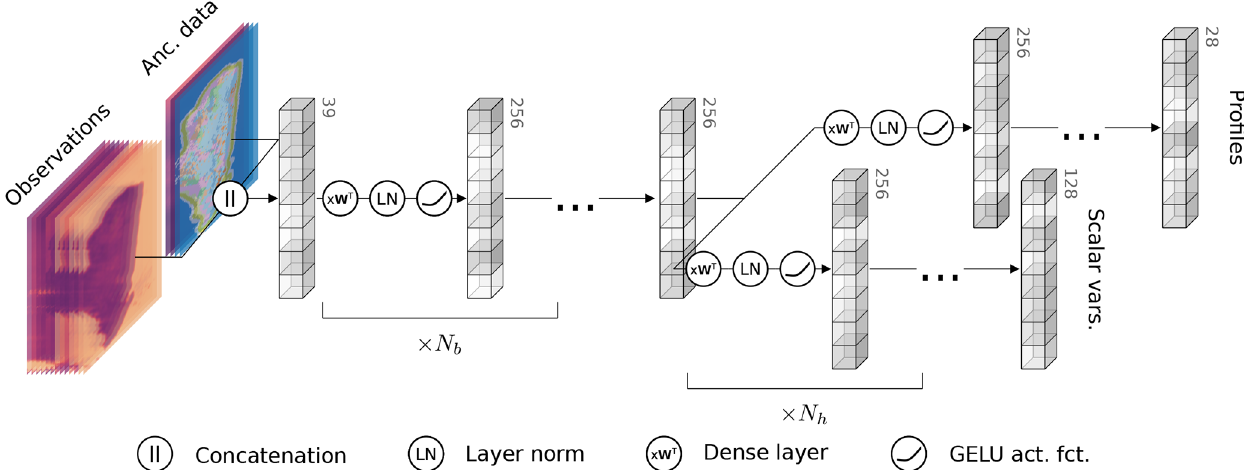
Figure 2. Illustration of the neural network architecture used in the GPROF-NN 1D algorithm. The network consists of a common body and one head for each retrieval variable. Each block in body and head consists of a fully connected layer, layer norm, and GELU activation function.